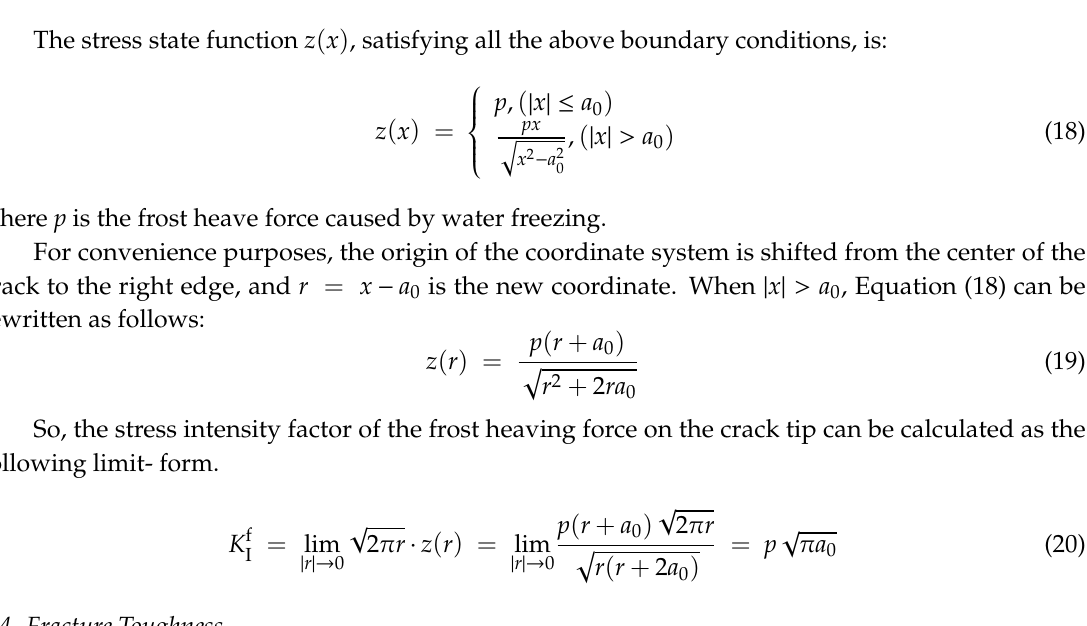
Figure 20. The relationship among stress field of